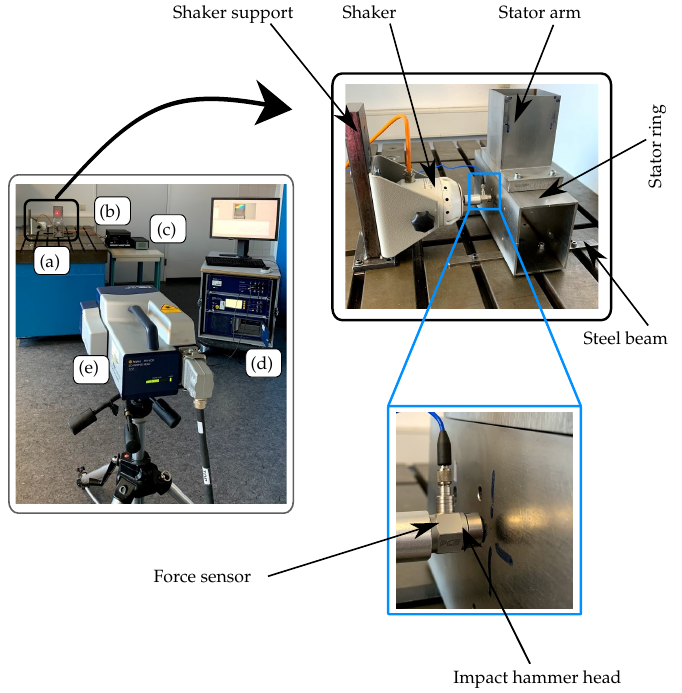
Figure4. Experimentalsetupofthewindturbinestatortestspecimenforevaluatingthetransmission Figure 4. Experimental setup of the wind turbine stator test specimen for evaluating the transmission path damping: (a) Test specimen, (b) Shaker power amplifier, (c) Force sensor amplifier, (d) Control path damping: ( a ) Test specimen, ( b ) Shaker power amplifier, ( c ) Force sensor amplifier, ( d ) Control and post-processing unit, (e) Laser vibrometer scan head. and post-processing unit, ( e ) Laser vibrometer scan head.